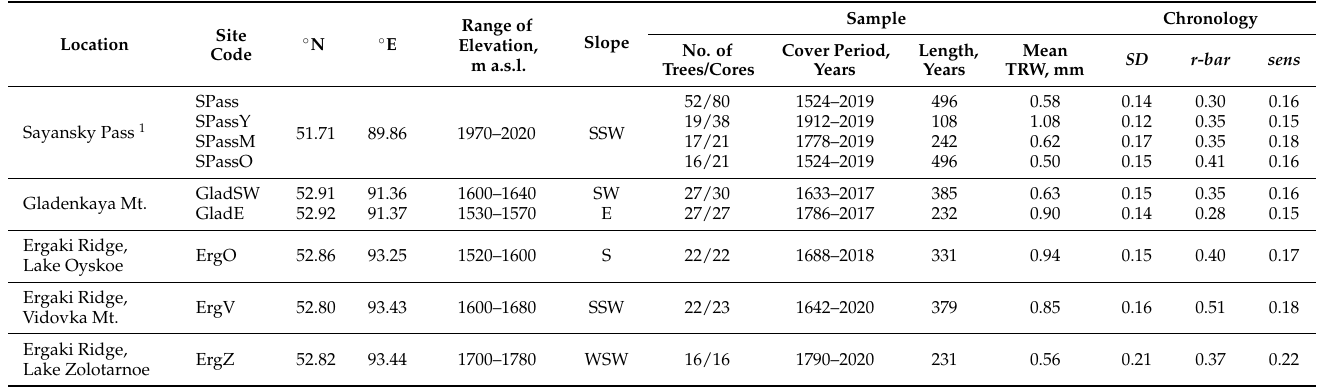
Table 1. Characteristics of sampling sites, samples and tree-ring width (TRW) chronologies ( SD , standard deviation; r-bar , mean inter-series correlation coefficient; sens , mean sensitivity